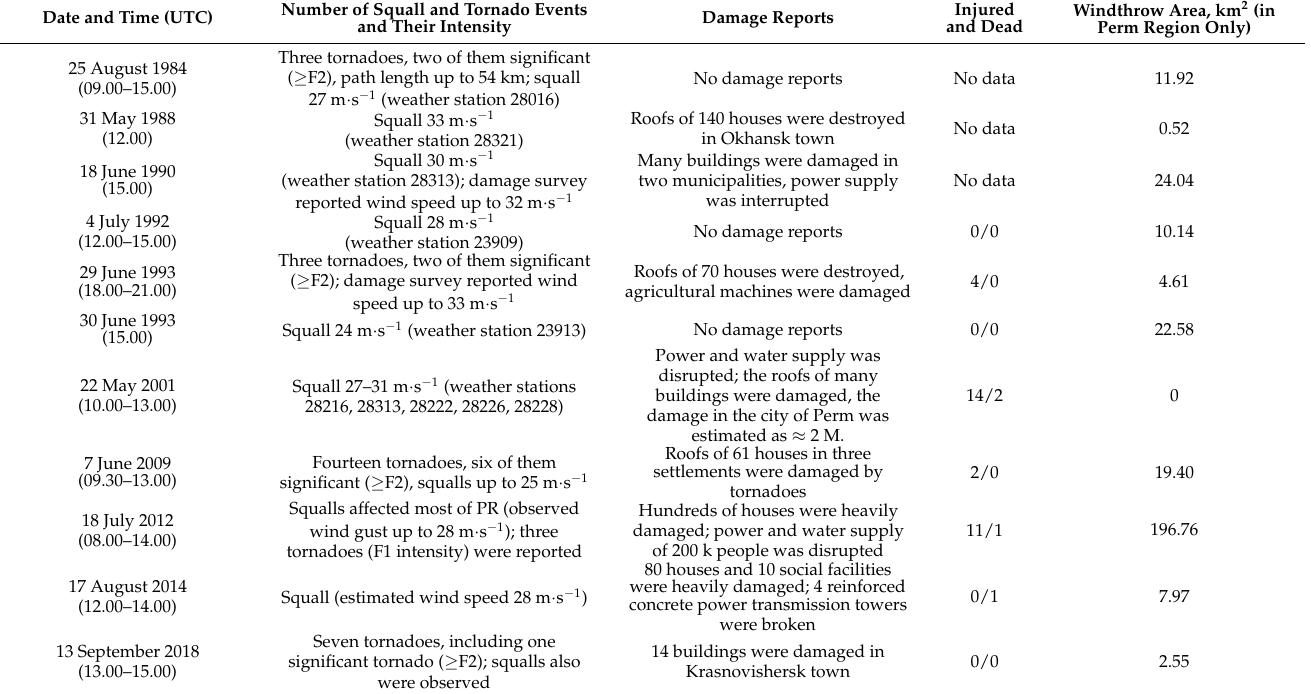
2 (in Perm Region